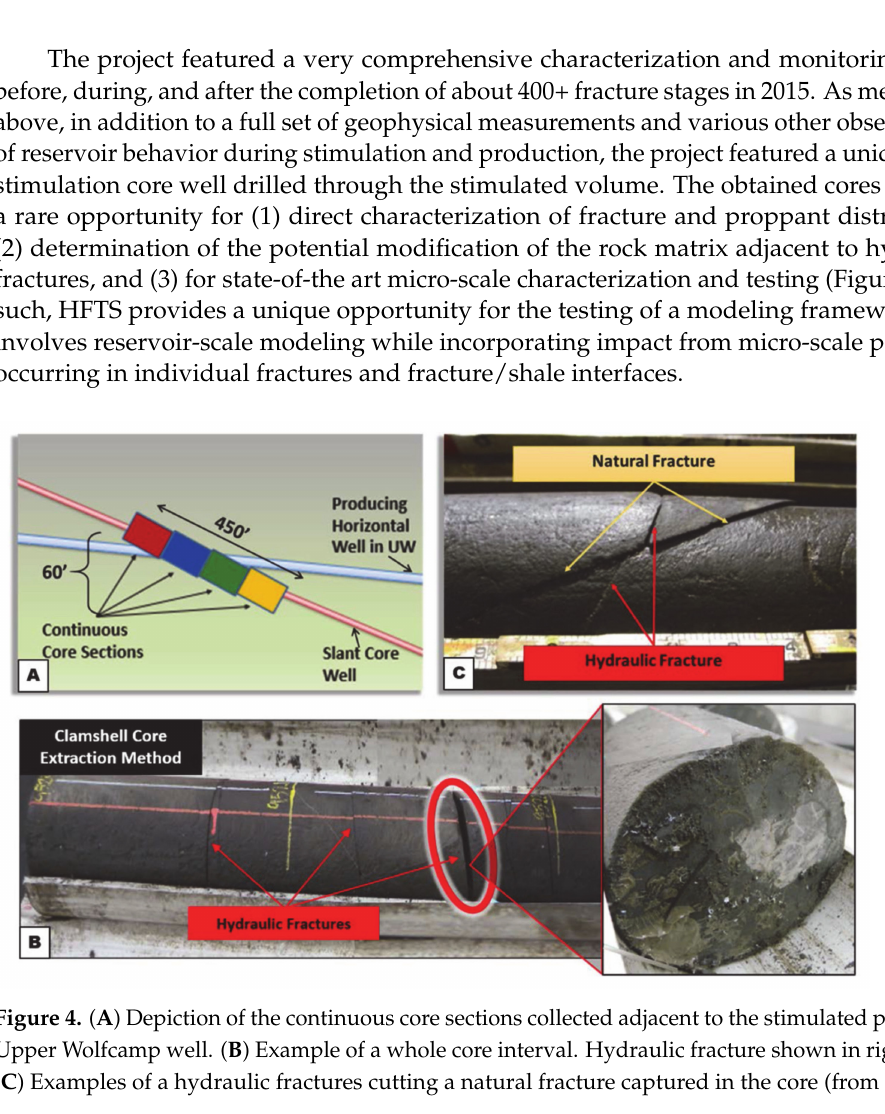
Figure 3. Left —Map showing the location of the HFTS experiment in the Permian Basin. Right —Details of the HFTS (from [26]).